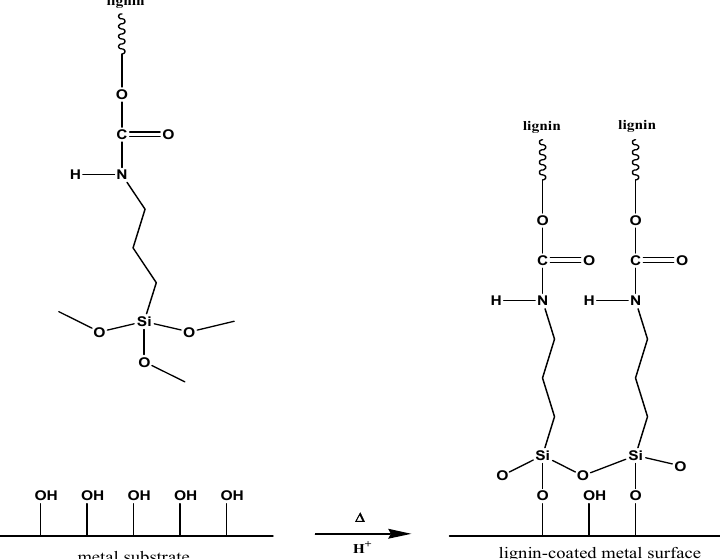
Figure 16. Schematic representation of the covalent bonding between lignin fractionalization and silanization (LF-S) and metal substrate promoted by the presence of acetic acid and heat. Adapted from [67], with permission from American Chemical Society and Copyright Clearance Center, 2019.